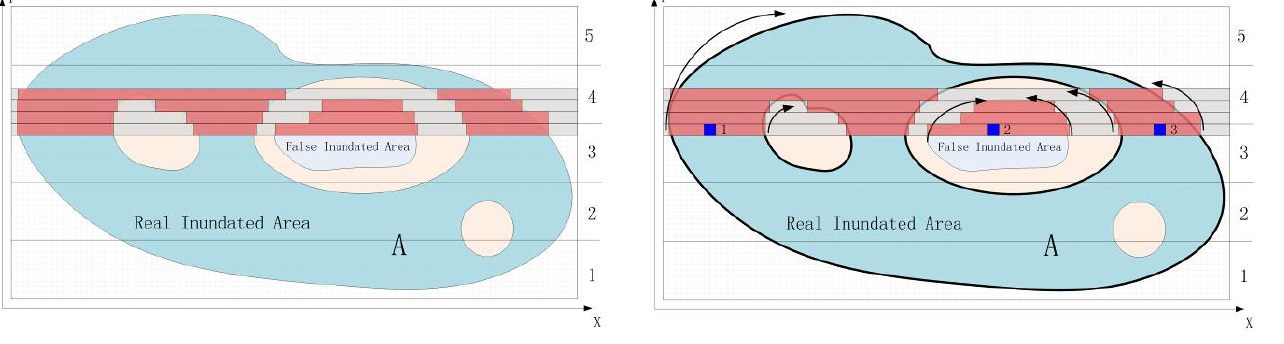
Figure 8. Connectivity detection between the digital elevation model (DEM) grid cells.